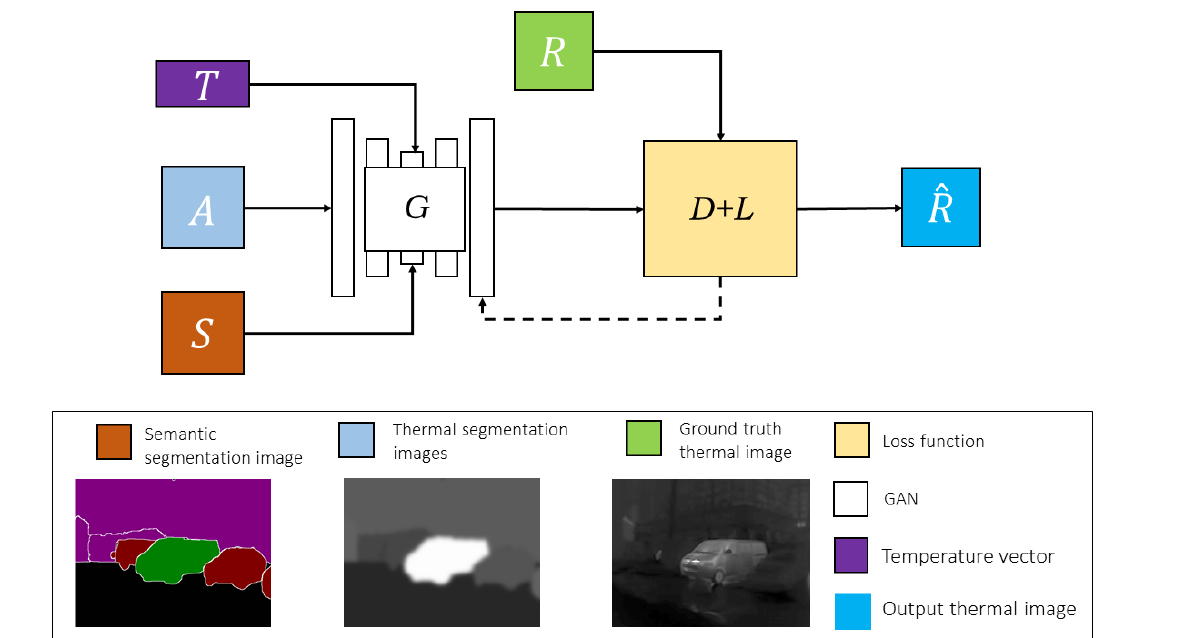
Figure 2. The pipeline of the first